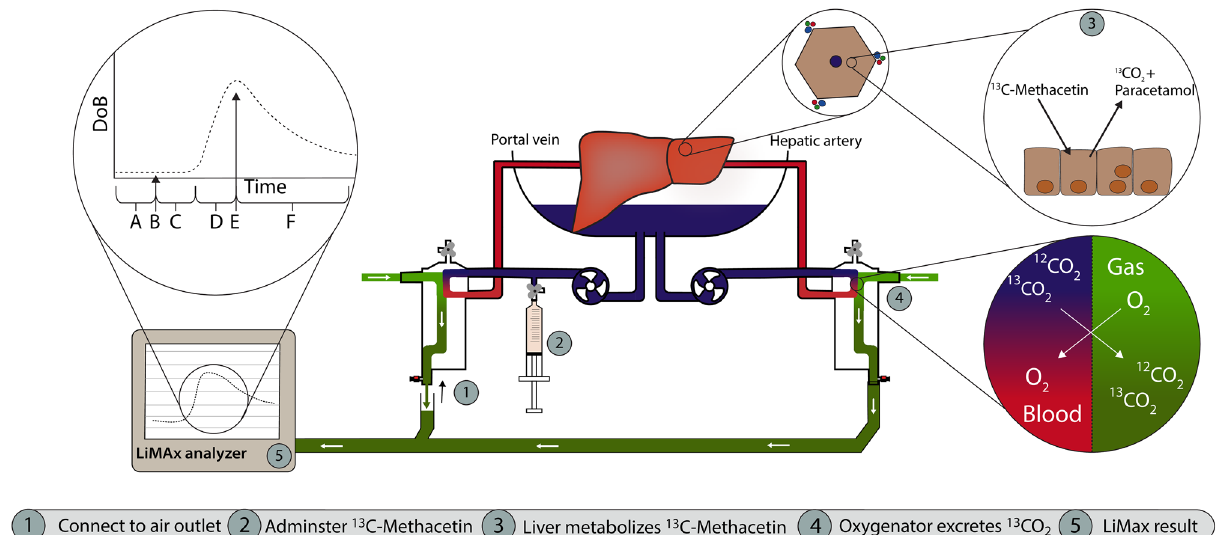
Figure 1. Overview of performing the LiMAx test in normothermic machine perfusion. (1) The LiMAx analyzer is connected to the air outlet of the membrane oxygenator. All extra air openings should be closed. (2) Then a baseline 13 CO 2 : 12 CO 2 ratio is measured, followed by administering the 13 C-methacetin. (3) The 13 C-methacetin is metabolized in the hepatocytes into 13 CO 13 CO 2 and paracetamol. (4) The 2 is excreted by the oxygenator from the perfusate into the “exhaled” air. (5) The LiMAx analyzer analyses the “exhaled” air, produces a curve illustrating delta over baseline (DoB) against the time in minutes. The LiMAx curve first presents the baseline that is being established (A), and then the 13 C-methacetin is administered (B), followed by a delayed signal time (the time until the first increase in 13 CO 2 is measured by the analyzer; (C). Then, there is an acceleration phase (D), followed by the DoB max (E), and finally resulting in an elimination phase (F) in which the signal slowly returns to the